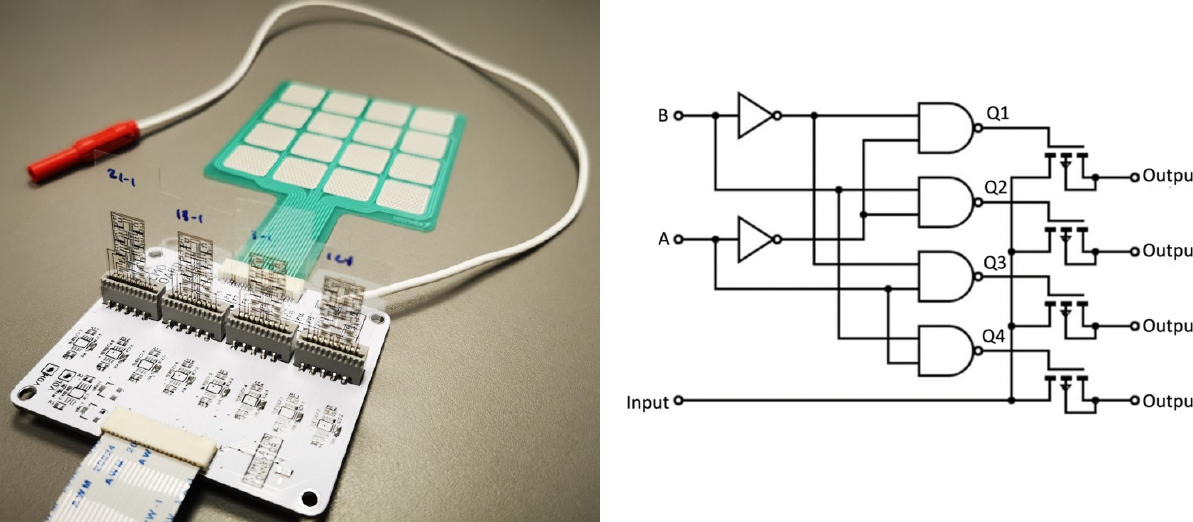
Figure 6. Left : Image of the testbed for validation of the switching capabilities of the OECT-based printed 2–4 demultiplexer circuits. The testbed enabled connection of up to four demultiplexer circuits, which allowed control of the current propagation over a 16-pad matrix electrode at the output. The flat cable at the input was connected to the MCU and the pulse generator boards shown in Figure 5. Right : The schematic of the screen-printed OECT-based 2–4 demultiplexer circuit used to route the stimulation signal to the selected pad of the multi-pad electrode.